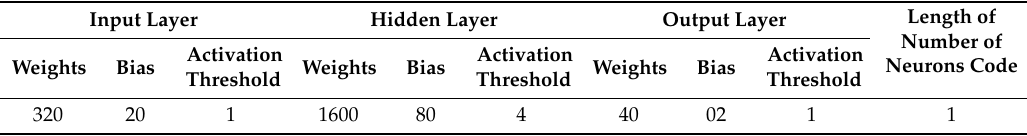
Table 7. Chromosome codification length.